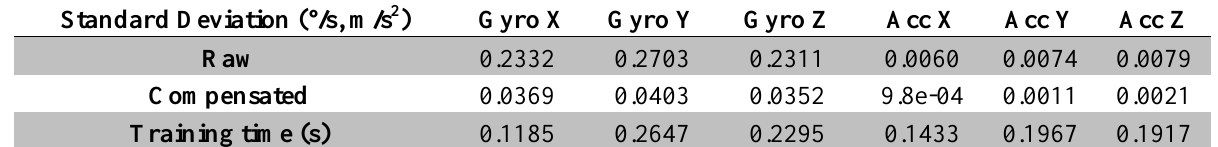
Table 7. Standard deviation of the raw and compensated datasets.